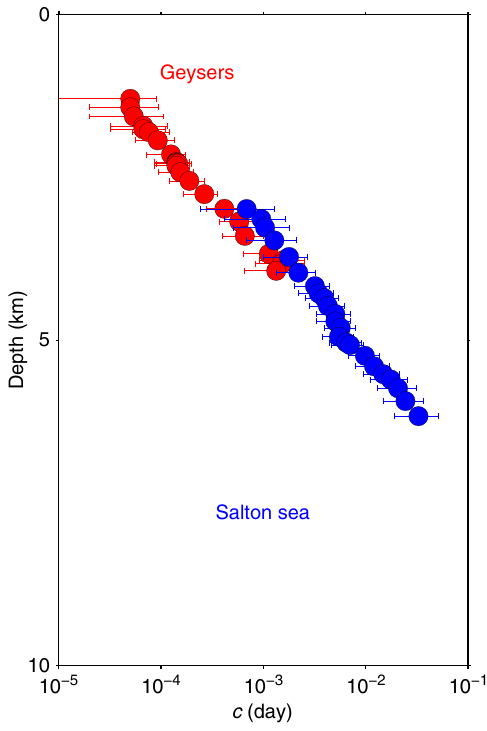
Fig. 3 In fl uence of depth on the time delay before the onset of the power- law aftershock decay rate in zones of fl uid-injection-induced seismicity. Logarithm of the most probable c -value for p = 1 with respect to the mean depth of the selected aftershocks within the 3 km depth bins in the Geysers (red) and Salton Sea (blue) areas. Error bars show the 95%